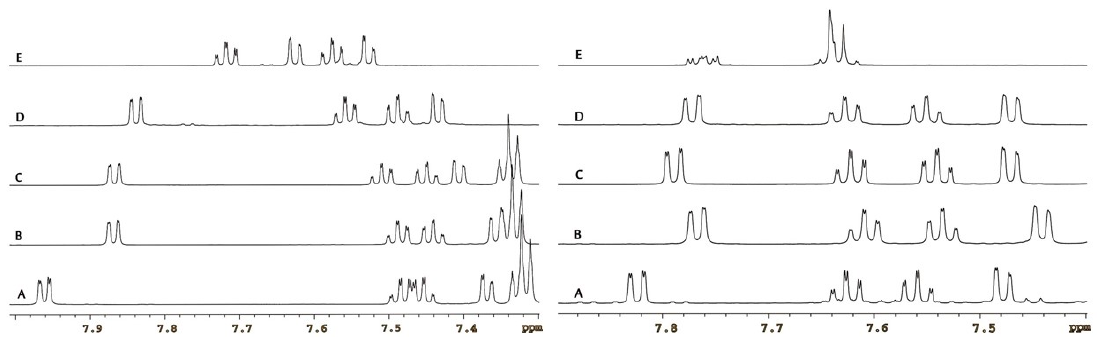
Figure 3. 1 H/ 13 C g-HMBC NMR spectrum of N -2 substituted dimedoxomil derivative 9 in CDCl 3 solution ( left ) and N -1 substituted dimedoxomil derivative 10 in CDCl 3 solution ( right ).